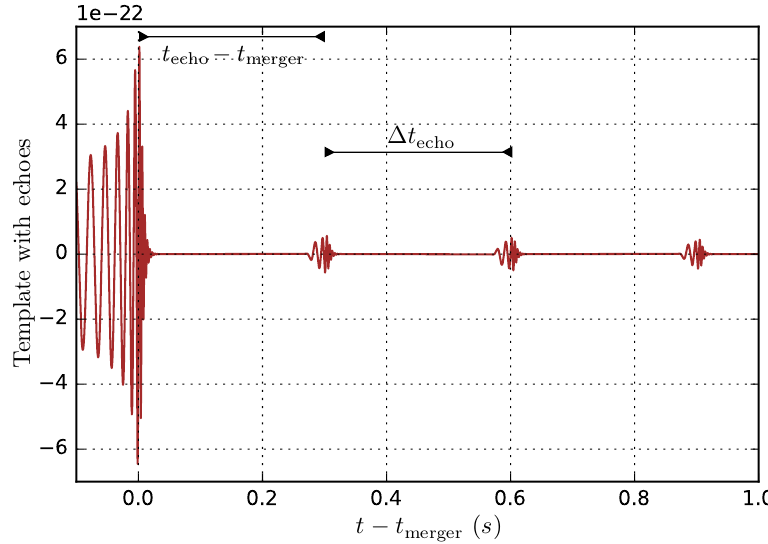
Figure 20. Original GW template of GW150914 [18], along with best fit echoes template (147). Table 5. Values of best fit echo parameters of the model Equation (147) of the highest SNR peak near the predicted ∆ t echo (gray rectangle in Figure 17), and their significance [18]. Range GW150914 Combined